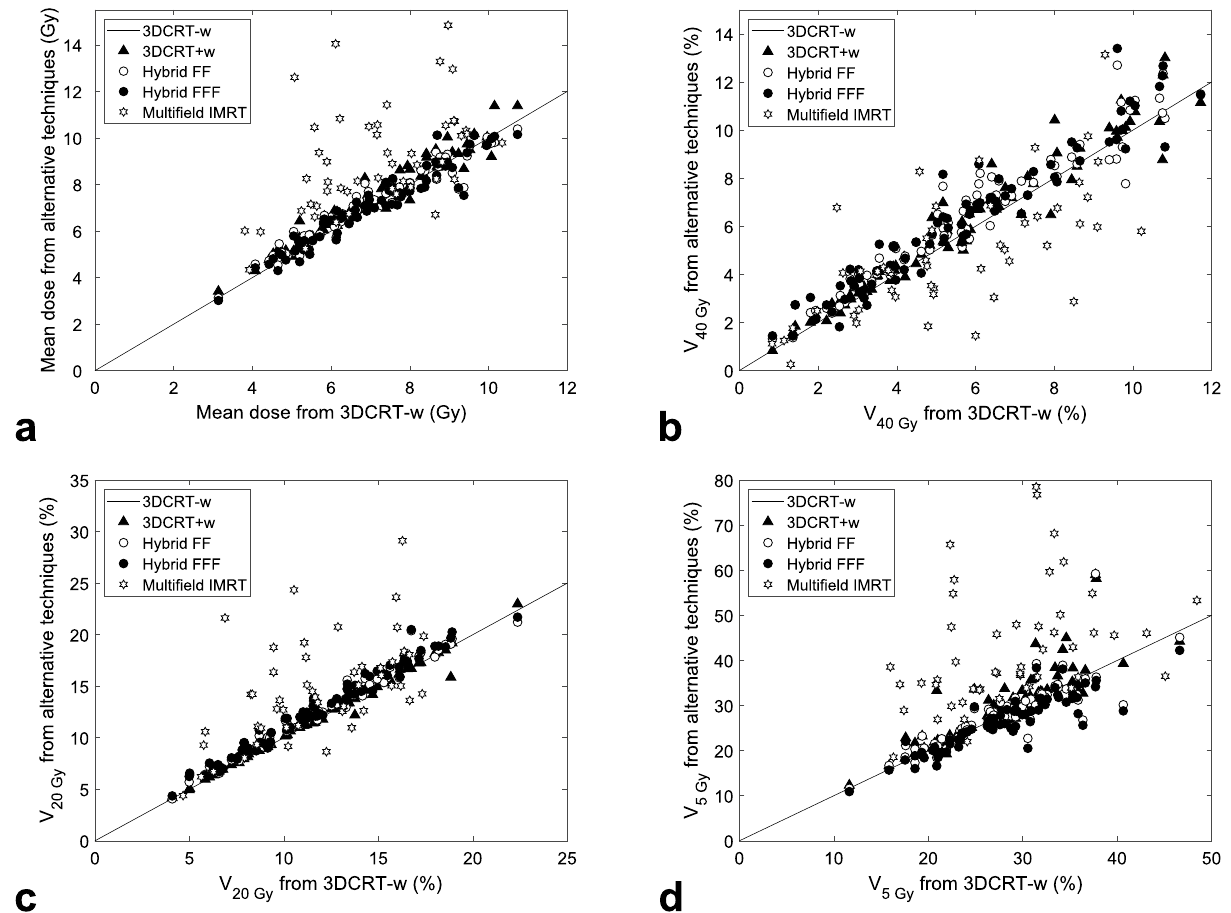
Figure 2. Lung exposure from alternative techniques of whole-breast irradiation with prescribed dose of 50.4 Gy. Displayed are ( a ) mean doses, ( b ) volume fractions V 40 Gy , ( c ) V 20 Gy and ( d ) V 5 Gy for ipsilateral lung, as calculated by the TPS. Data from 3DCRT with wedges (triangles), hybrid technique with a flattening filter (empty circles), hybrid flattening filter-free technique (full circles) and multi-field IMRT (hexagrams) are plotted against those for 3DCRT without wedges for the same patient. Points above (or below) the identity line mean that the given technique resulted in a higher (or lower) dose than